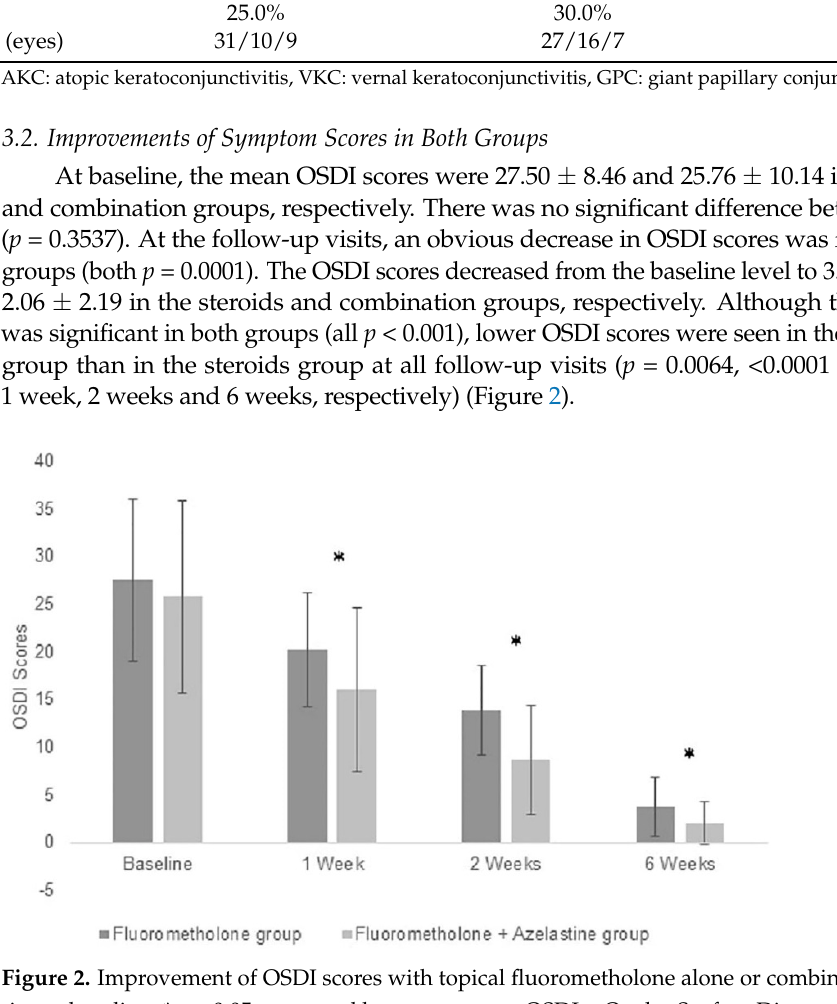
Table 2. Patient demographic characteristics at baseline.